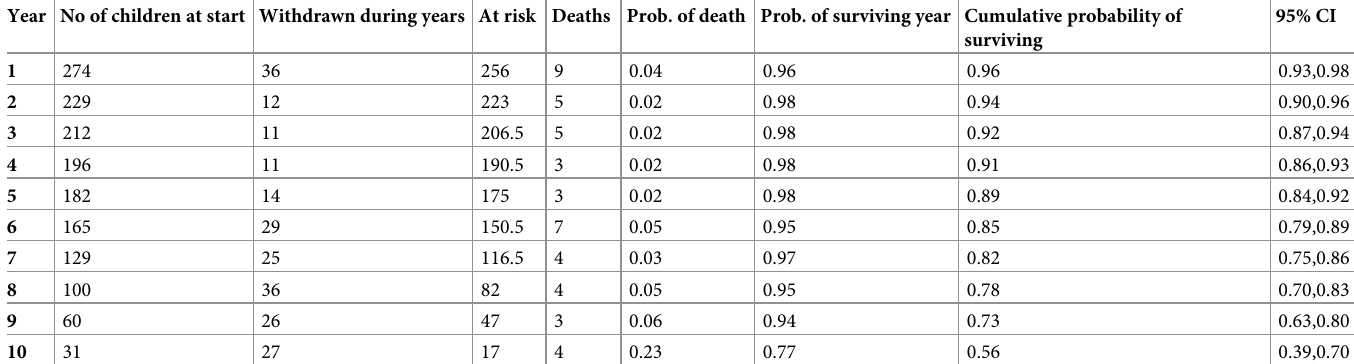
Table 4. Life table showing the cumulative survival probability among TB/HIV co-infected children at public hospitals in Southern Ethiopia, 2020. Year No of children at start Withdrawn during years At risk Deaths Prob. of death Prob. of surviving year Cumulative probability of